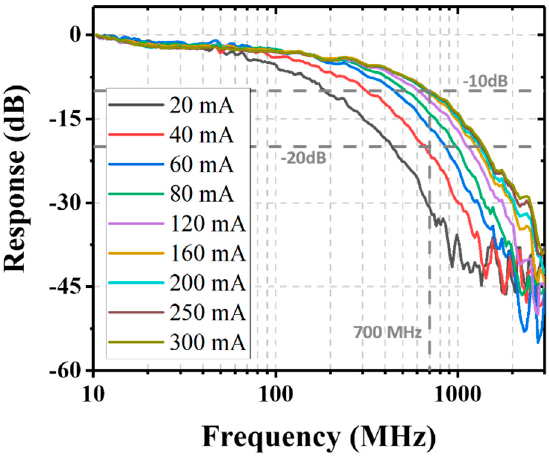
Figure 5. The frequency response of the blue SLD-based VLC system.